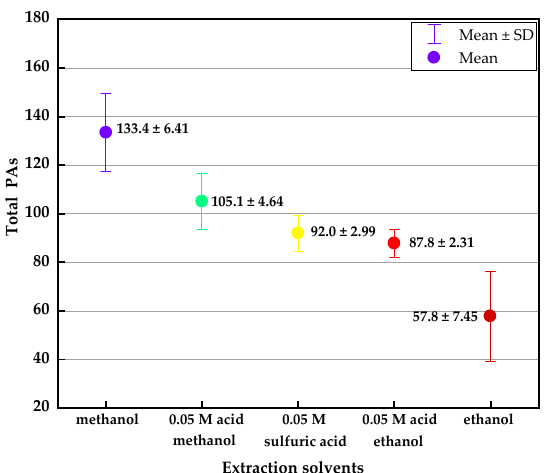
Figure 2. Effect of five different extraction solvents on the total PAs. Acid methanol: sulfuric acid in methanol, sulfuric acid: sulfuric acid water, acid ethanol: sulfuric acid in ethanol. The total PAs concentrations (mean ± SD, μ g/kg) of different solvents are marked in the graph. SD: standard deviation, represents the deviation of three parallel samples with different solvents.